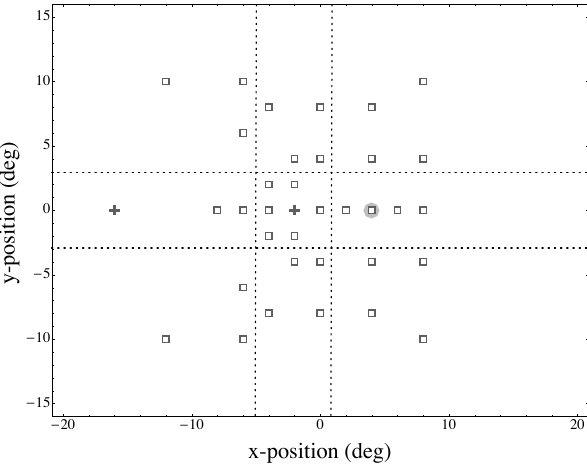
Figure 3 . Testing field in the short saccade experiment. Crosses indicate the 14 deg saccade from FP to T1. The filled circle indicates adaptation position T2, 6 deg rightwards from T1. Open squares are the 34 testing positions. For the long saccade experiment all testing positions were 6 deg more to the